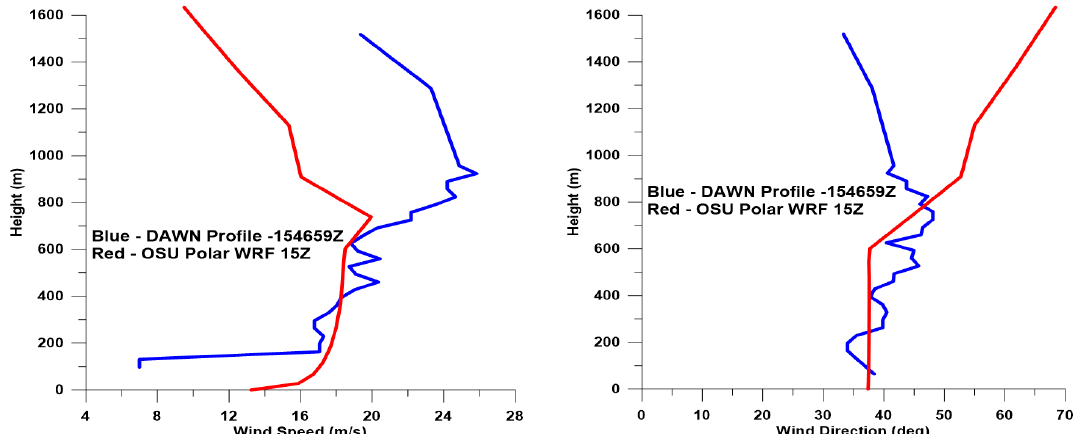
Figure 21. DAWN and model profiles of wind speed ( left ) and wind direction ( right ) near 1523Z on 31 October 2014 for the beginning of leg 7 south of the tip.